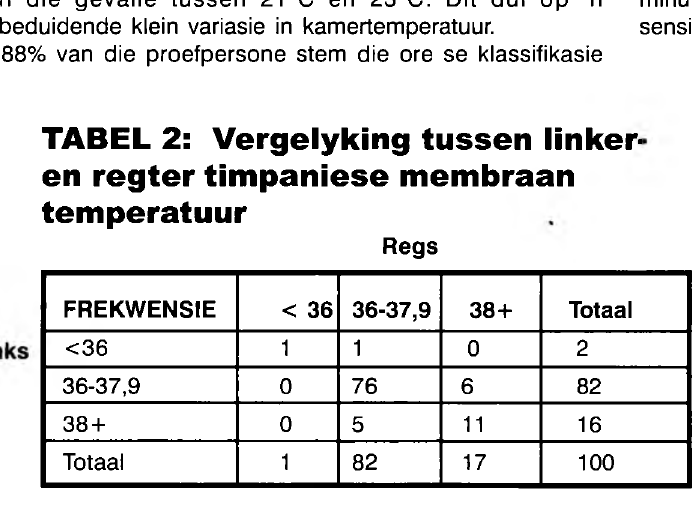
VERSKILLE TUSSEN METING